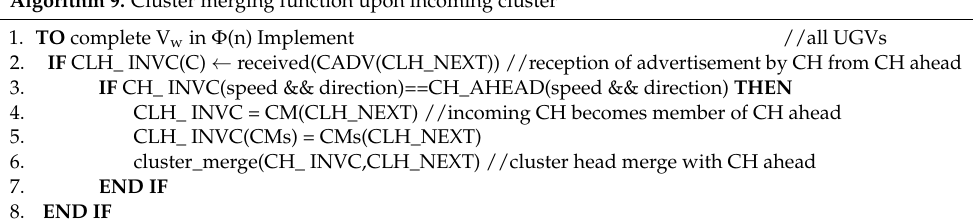
Algorithm 9. Cluster merging function upon incoming